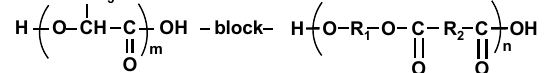
Figure 2. Chemical structural formula of the soft resin. Table 1. Samples of PLA with soft resin added.